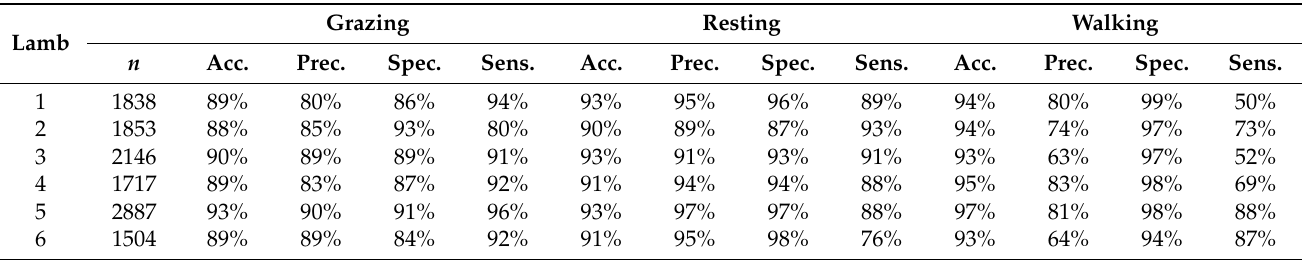
Table 6. Performance of the random forest classification algorithm predictions across individual ewe lambs ( n = 6). Data shown for each lamb when data for other 5 lambs were used to develop the algorithm. Grazing Resting Walking Lamb n Acc. Prec. Spec. Sens. Acc. Prec. Spec. Sens. Acc. Prec. Spec.